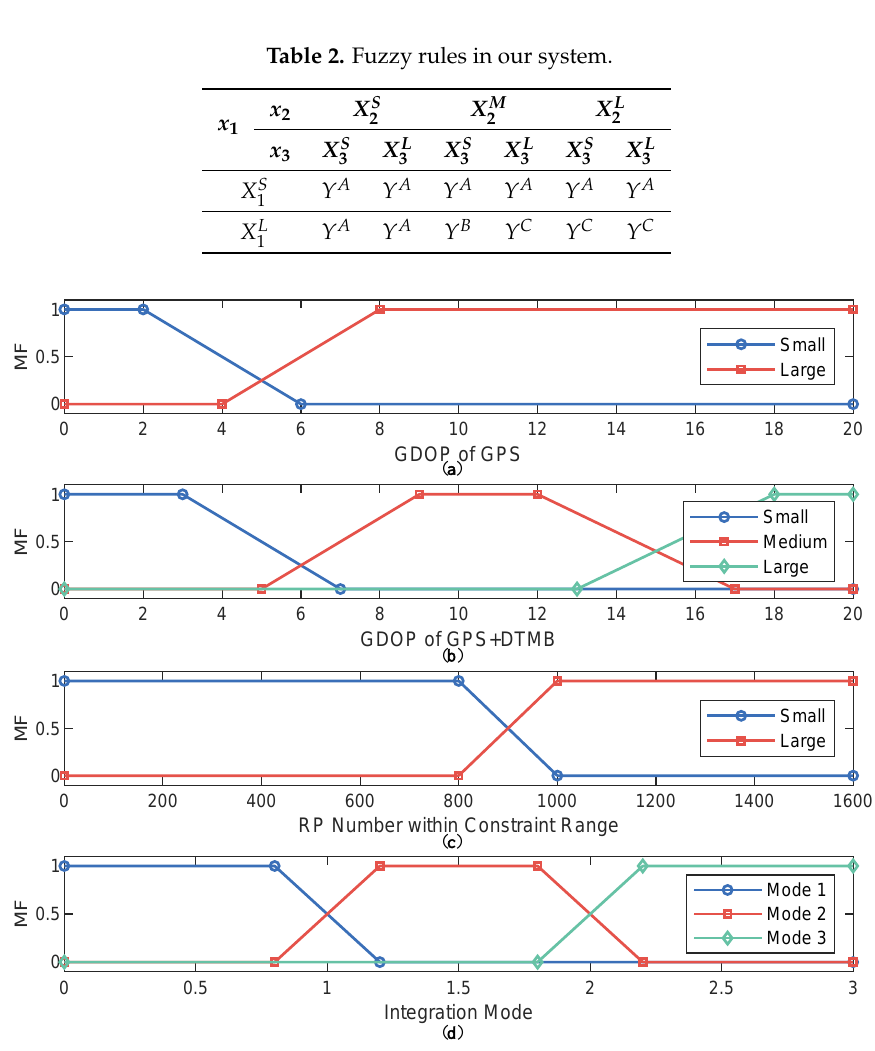
Figure 4. Membership functions in our fuzzy inference system: ( a ) membership function for GDOP of GPS; ( b ) membership function for GDOP of GPS + DTMB; ( c ) membership function for RP number within constraint range; and ( d ) membership function for system output (integration